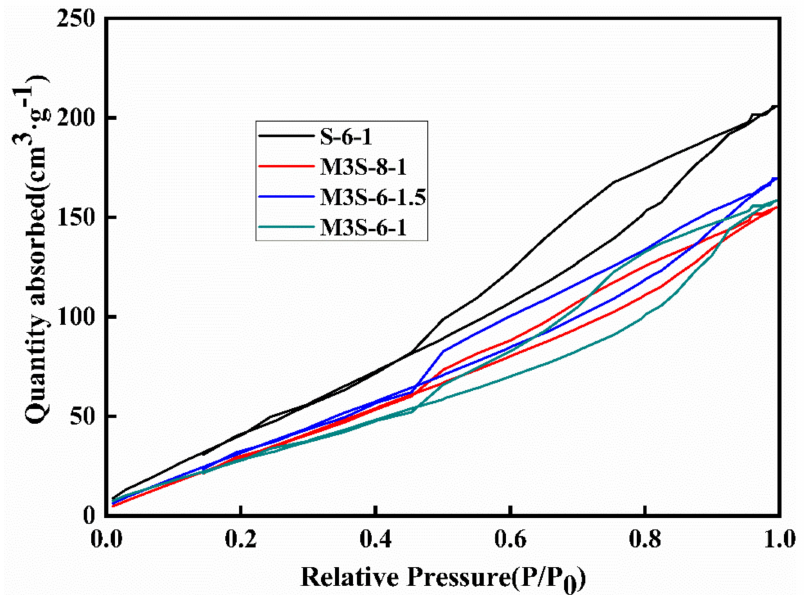
Figure 15. Isothermal adsorption–desorption curves of alkali-activated slag containing 30% metakaolin with different activator concentrations and